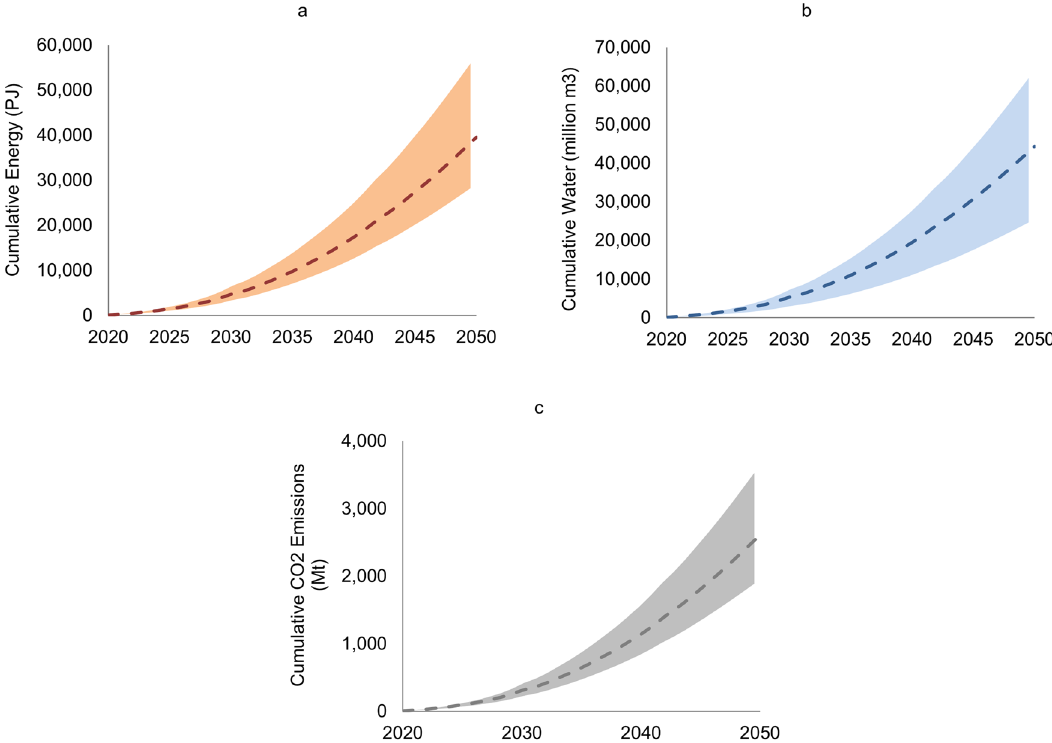
Fig. 4 Energy, water, and CO 2 emissions associated with oversupplied REEs in high demand scenarios. Cumulative a energy, b water, and c CO 2 emissions associated with the oversupplied REEs in the high demand scenarios as a result of Dy demand based on the lower, higher, and average